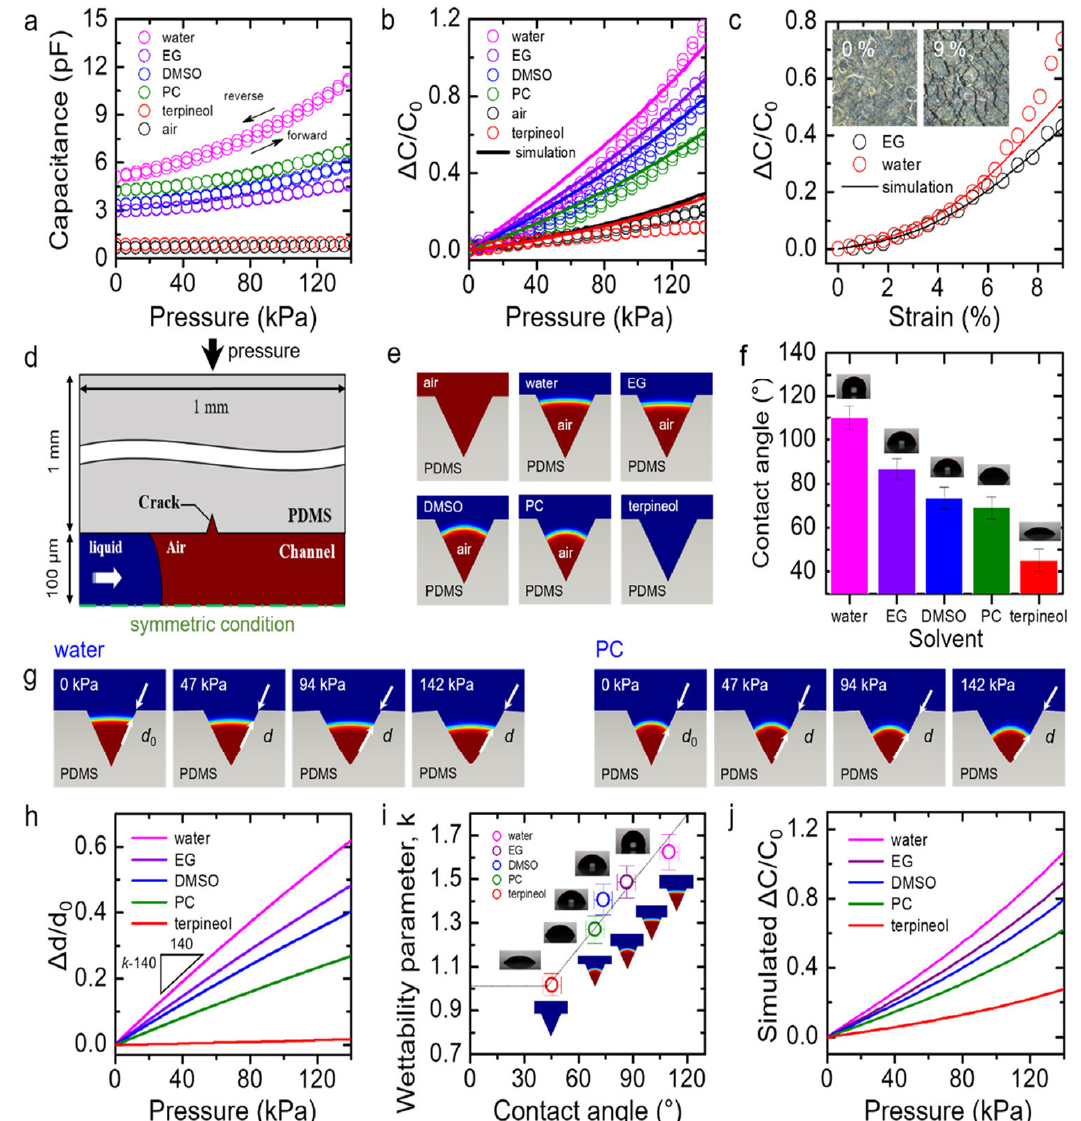
Figure 3. ( a ) An analysis of the capacitance at 0–140 kPa as a function of applied pressure for crack-enhanced microfluidic pressure sensors prepared with five sensing liquids. ( b ) Normalized capacitance plotted as a function of all sensors. The values simulated are represented by solid lines. ( c ) Normalized capacitance of EG or water-based sensors as a function of train, ranging from 0% to 9%. ( d ) The channel and crack simulated in the COMSOL are depicted schematically in this diagram. ( e ) In each liquid example, COMSOL modeling results were achieved under the initial conditions, simulating the interface in the crack after filling the channel. ( f ) Angles of contact between liquids and the PDMS surface. ( g ) COMSOL modeling results produced by COMSOL for the water and PC under various pressure settings. ( h ) Simulated ∆ d/d 0 vs. the applied pressure corresponding to each. ( i ) Wettability parameters (k) plotted as function of contact angle. ( j ) Illustration of the simulated normalized capacitance as function of the pressure [83]. Copyright 2017, American Chemical